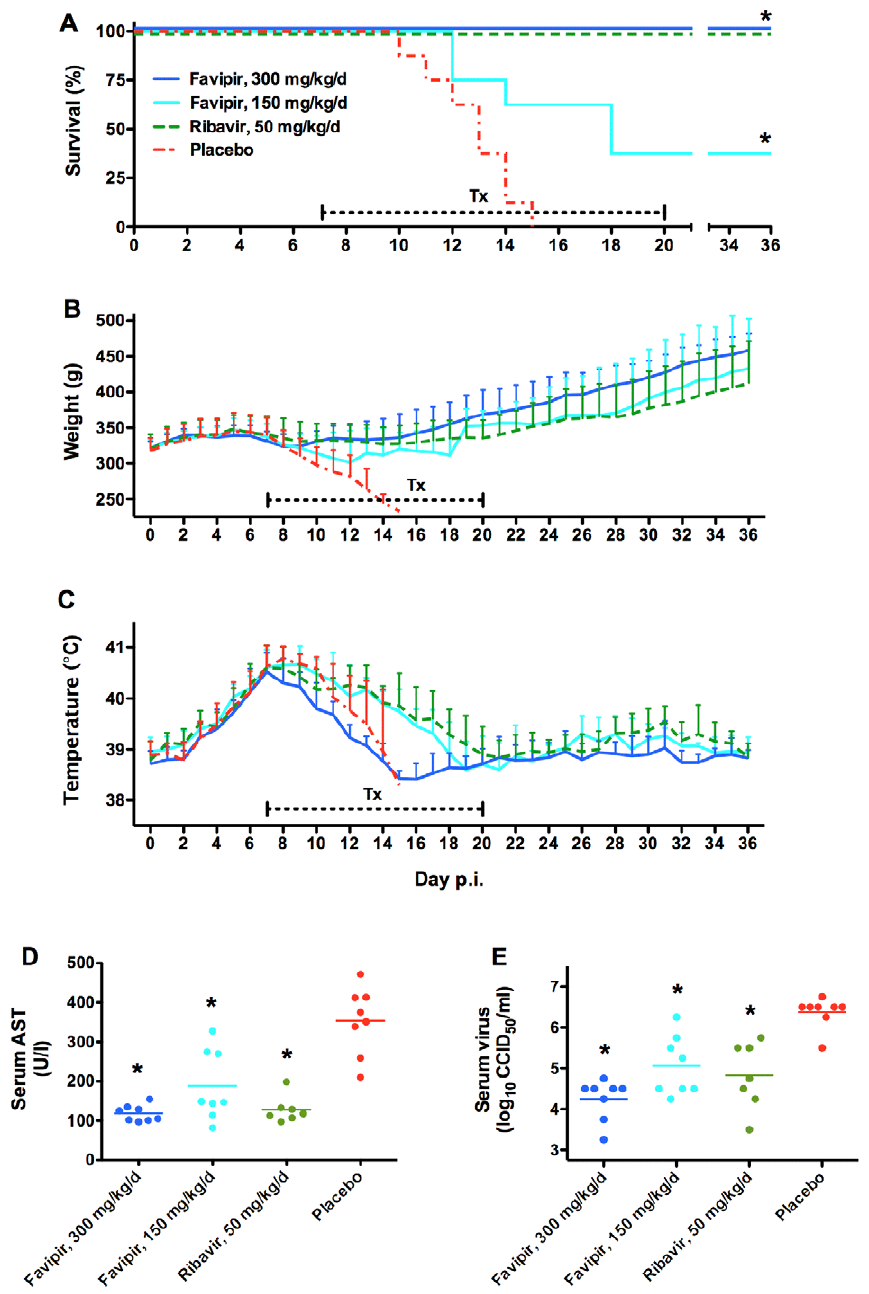
Figure 4. Favipiravir treatment of advanced PICV infection in guinea pigs. Guinea pigs (n=7–8/group) challenged with 500 PFU of p19 PICV were treated with the indicated dosages of favipiravir, ribavirin, or placebo beginning on day 7 of infection. The 150-mg/kg/d group received a loading dose of 300 mg/kg/d on the first day of treatment. Drugs were administered twice daily for 14 days (capped hashed line) and (A) survival, (B) body weights, and (C) temperatures were monitored for 36 days. Serum was collected on day 10 for analysis of (D) AST and (E) viremia. * P , 0.05 compared to placebo-treated animals.